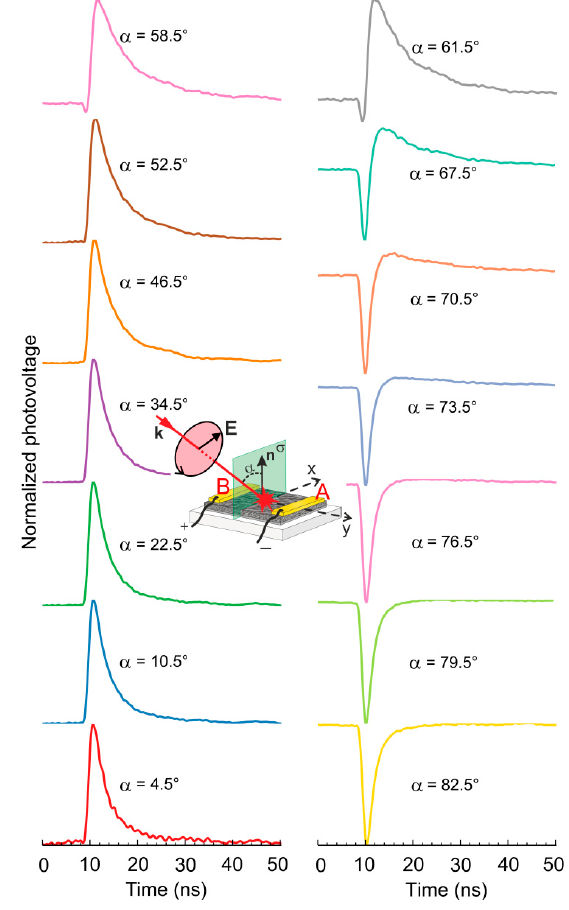
Figure 5. The waveforms of the transverse photovoltage pulses normalized to their extreme values for circularly polarized incident radiation, recorded for different angles of incidence α . The inset shows the sketch of the experimental setup.